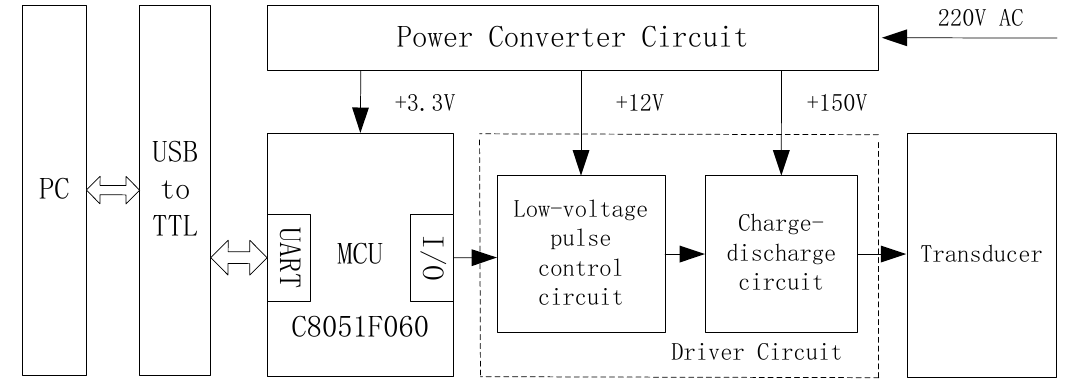
Figure 4. Pulse position modulation (PPM) signal generator design.